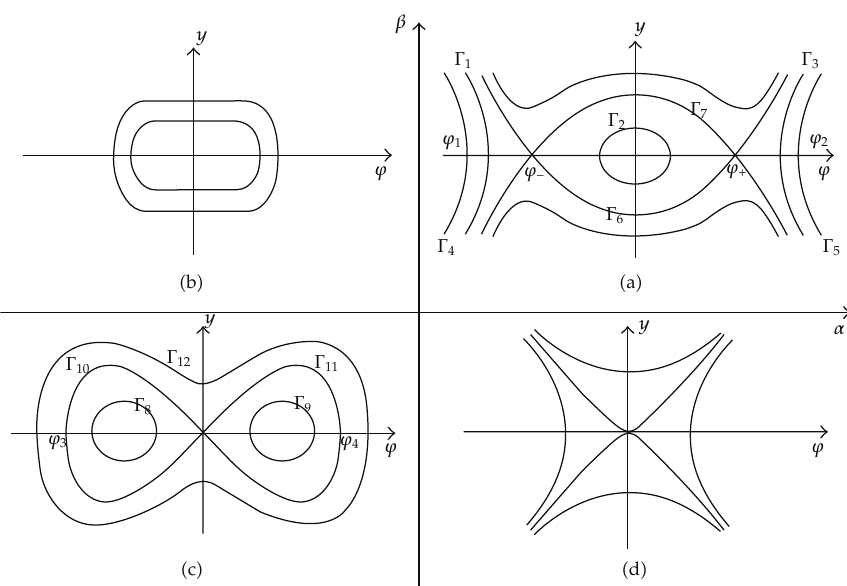
Figure 1: The bifurcation phase portraits of system (cid:4) 2.5 (cid:5) . (cid:4) a (cid:5) α > 0, β > 0, (cid:4) b (cid:5) α < 0, β (cid:2) 0, (cid:4) c (cid:5) α < 0, β < 0, (cid:4) d (cid:5) α > 0, and β (cid:3)